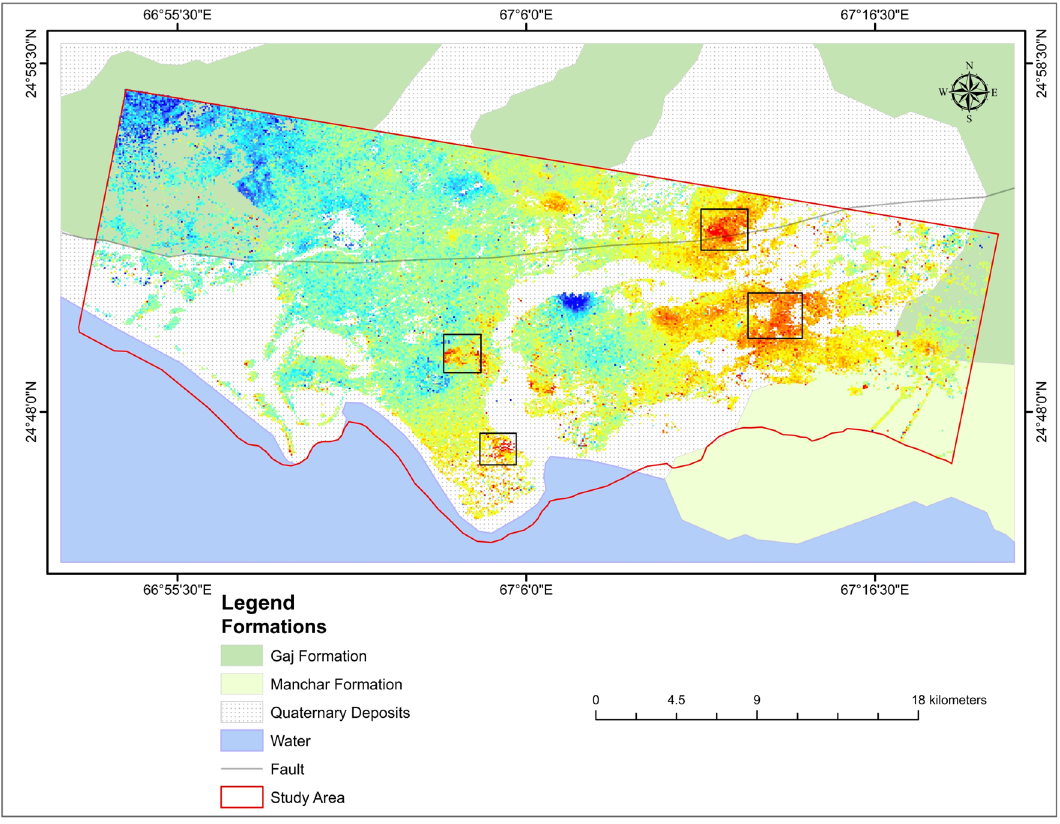
Figure 16. Subsidence on Geological